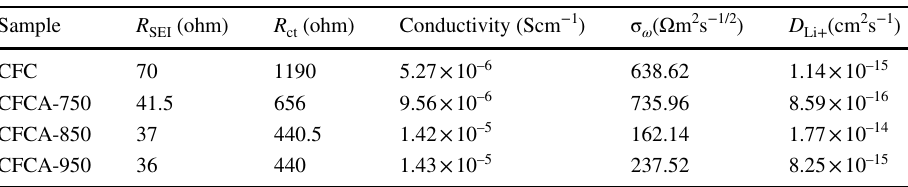
Table 4 EIS parameters and Li-ion diffusion of CFC and CFCAs